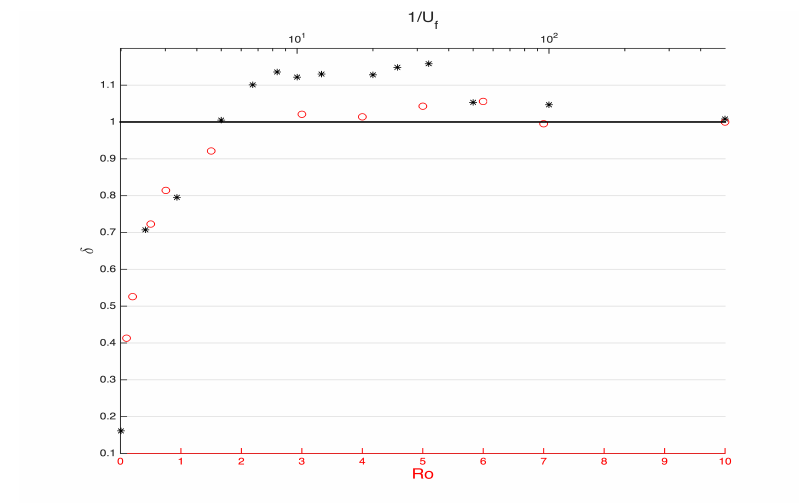
Figure 4. Red circles: Method 1, ratio δ of the Nusselt number Nu ( Ro ) in the presence of global rotations to Nu ( ∞ ) (no rotation). Black stars: Method 2, ratio δ of the Nusselt number Nu ( U f ) in the presence of azimuthal velocity boundary conditions to Nu ( 0 ) (no rotation).